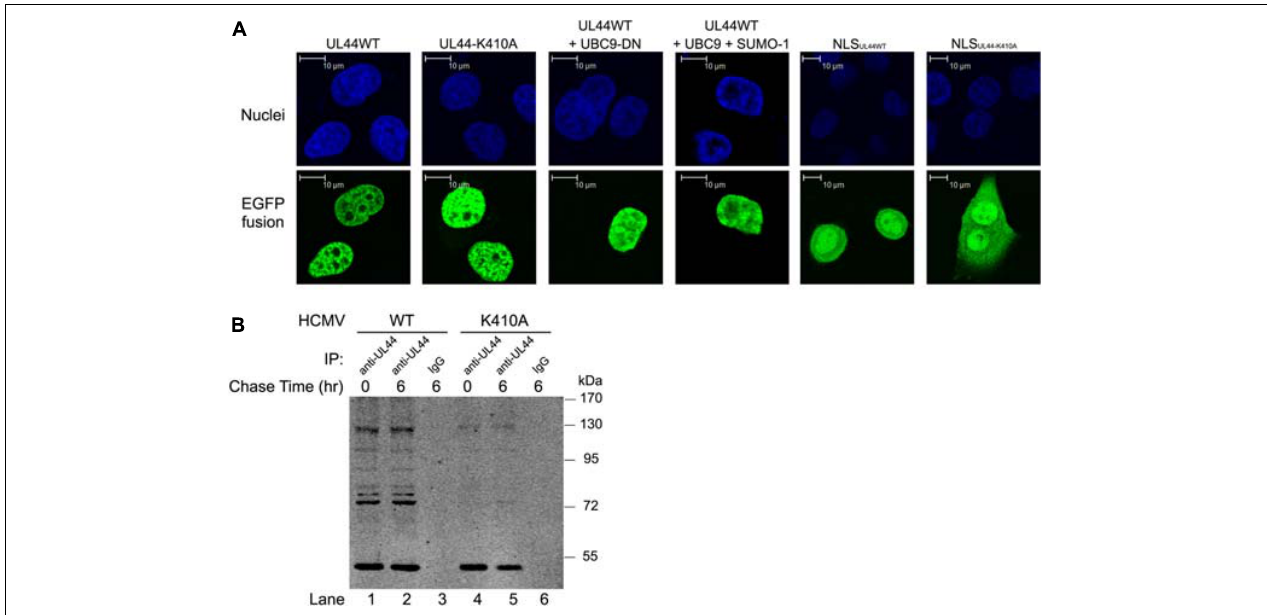
FIGURE 5 | 410 lysine had no effects on subcellular localization or protein stability of UL44. (A) Hela cells were transfected with constructs encoding fusion proteins EGFP-UL44WT, EGFP-UL44-K410A, EGFP-NLS UL 44 WT , EGFP-NLS UL 44 - K 410 A , and UBC9 or SUMO-1 alone or together as indicated in figure, stained with Hoechst 33258 to visualize cell nuclei. Confocal microscopy showed mutation of 410 lysine had no effect on the nuclear localization of UL44. (B) HFFs were